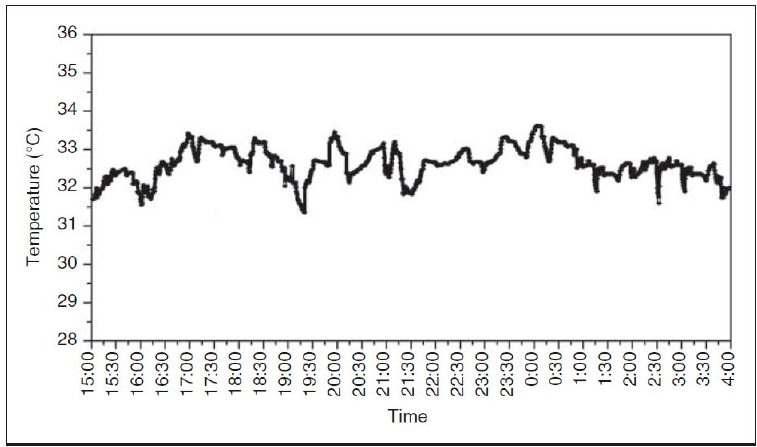
Figure 10. Greywater output from a commercial hotel and spa in China [32].